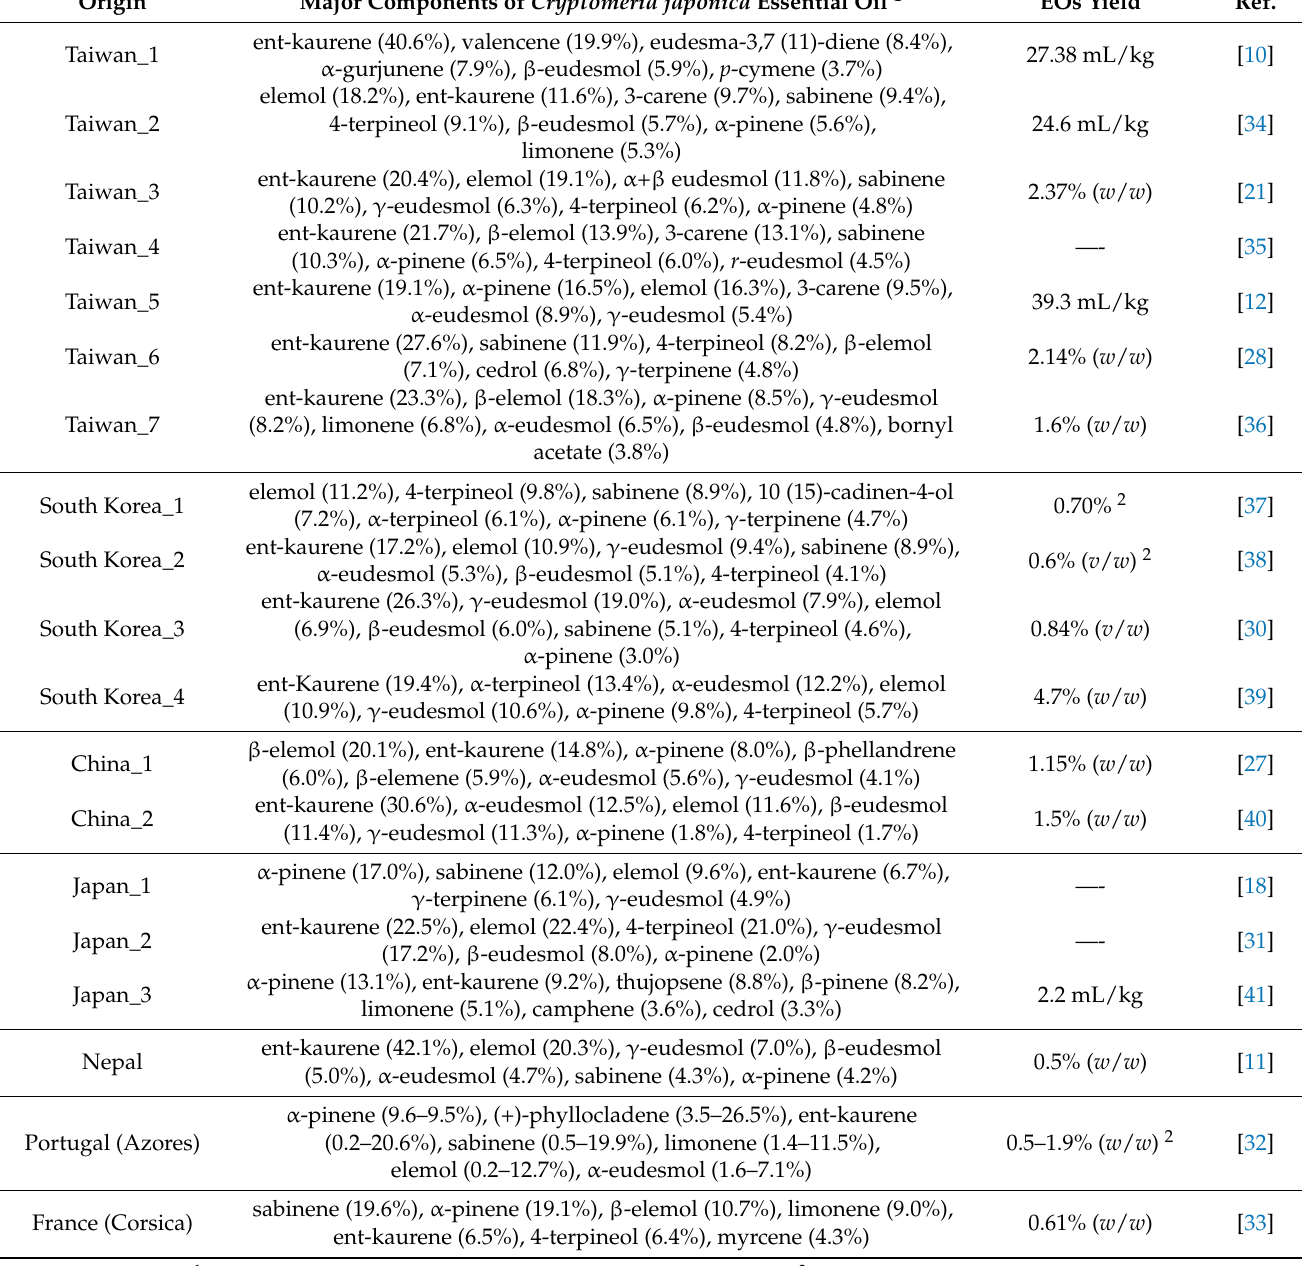
Table 1. Yield and major components of Cryptomeria japonica leaf EO from different geographical origins. Origin Major Components of Cryptomeria japonica Essential Oil 1 EOs Yield